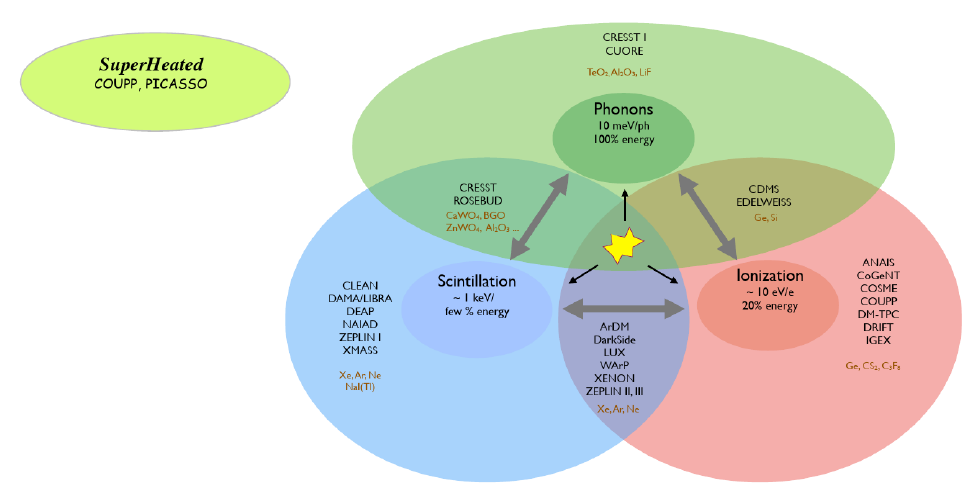
Figure 14: Signatures for detecting electron and nuclear recoils in materials and experiments that employ them individually or in